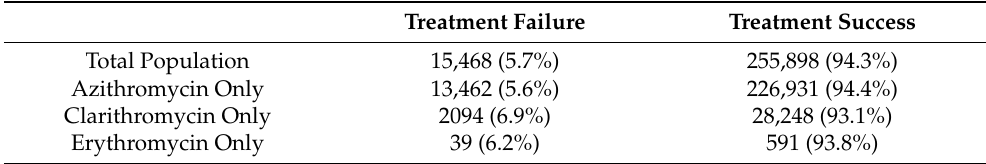
Table 3. Summary of the macrolide treatment failure rates within the common acute infection analysis for the total study population and broken down by macrolide used. Data are presented as absolute number, as well as